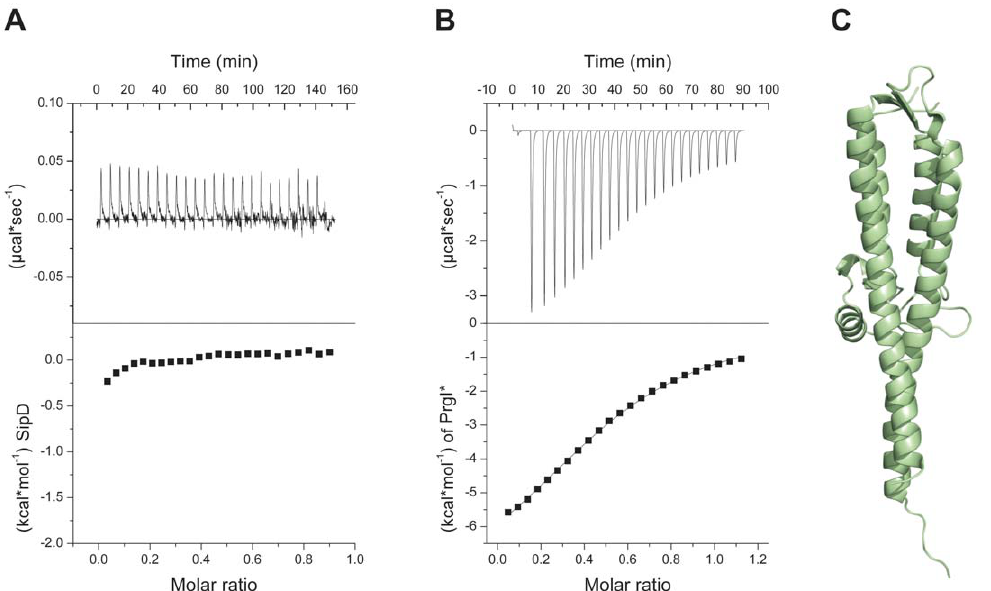
Figure 2. Deletion of SipD domain 1 permits binding to PrgI*. (A) Binding between S. typhimurium needle protein PrgI* and SipD was not detectable using isothermal titration calorimetry (ITC). Heat flow for each SipD injection as a function of time (upper) and integration of the thermogram (lower). (B) ITC of purified proteins PrgI* with SipD D D1 indicated a binding affinity of 88 6 3 m Mol. Heat flow for each PrgI* injection as a function of time (upper) and integration of the thermogram with the fitting curve (lower). (C) X-ray crystal structure of SipD D D1 .